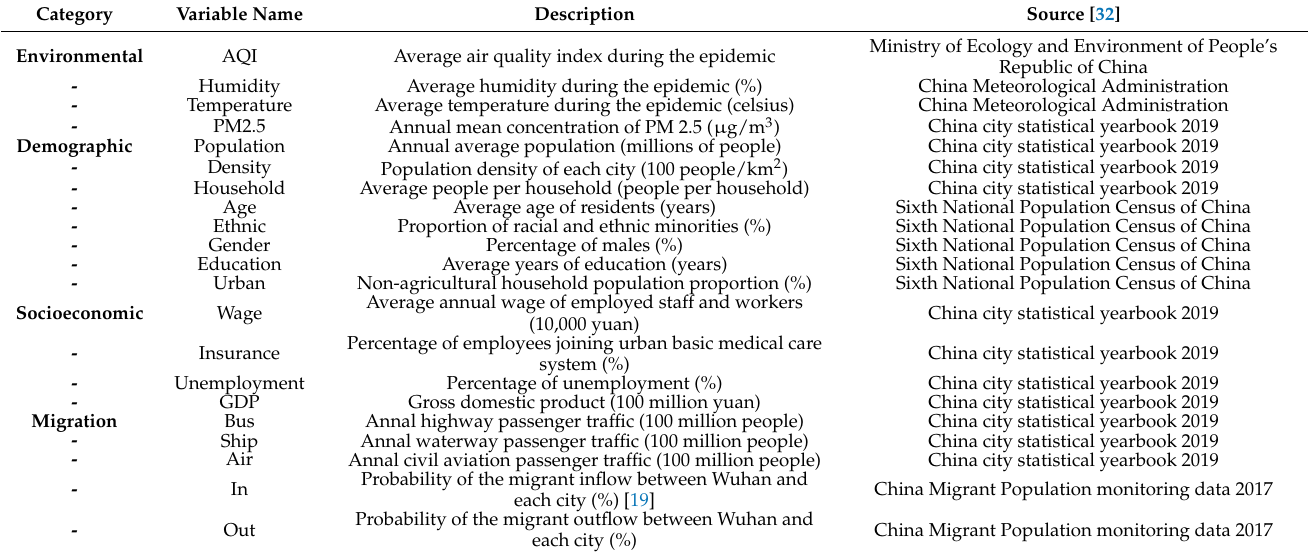
Table 1. Explanatory variables used in this study together with